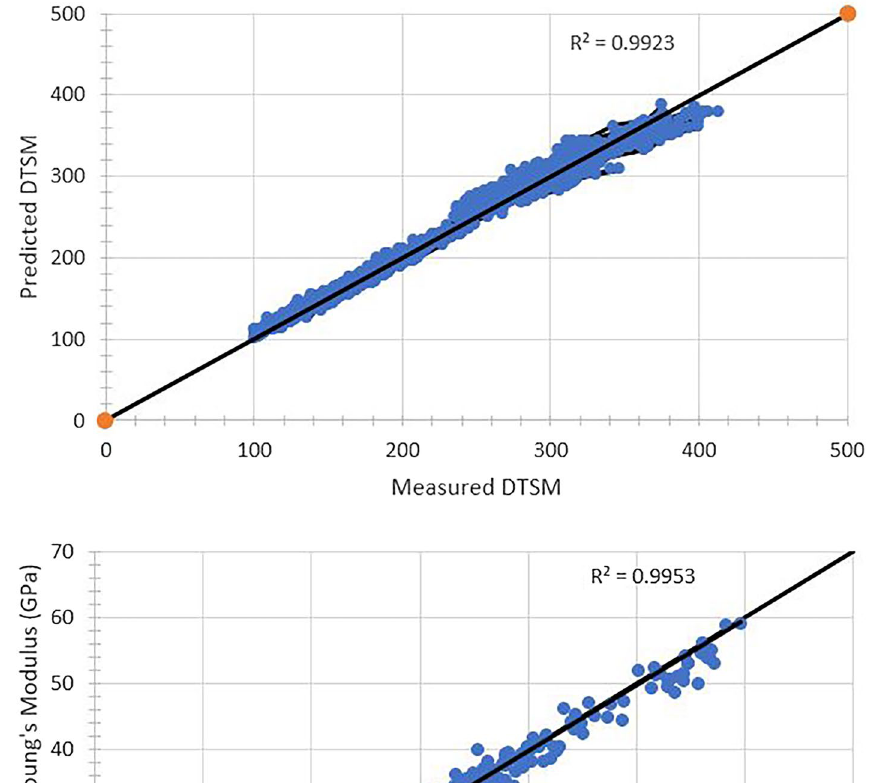
Fig. 10 Cross-validation plot of predicted and measured dynamic Young’s modulus